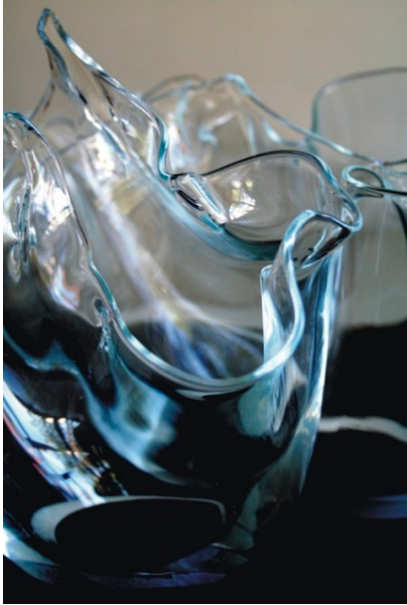
Figure 9. Glassblowing pieces by João Pedro Silva (glassblower Jorge Mateus), 2008. Photo credit: the artist.